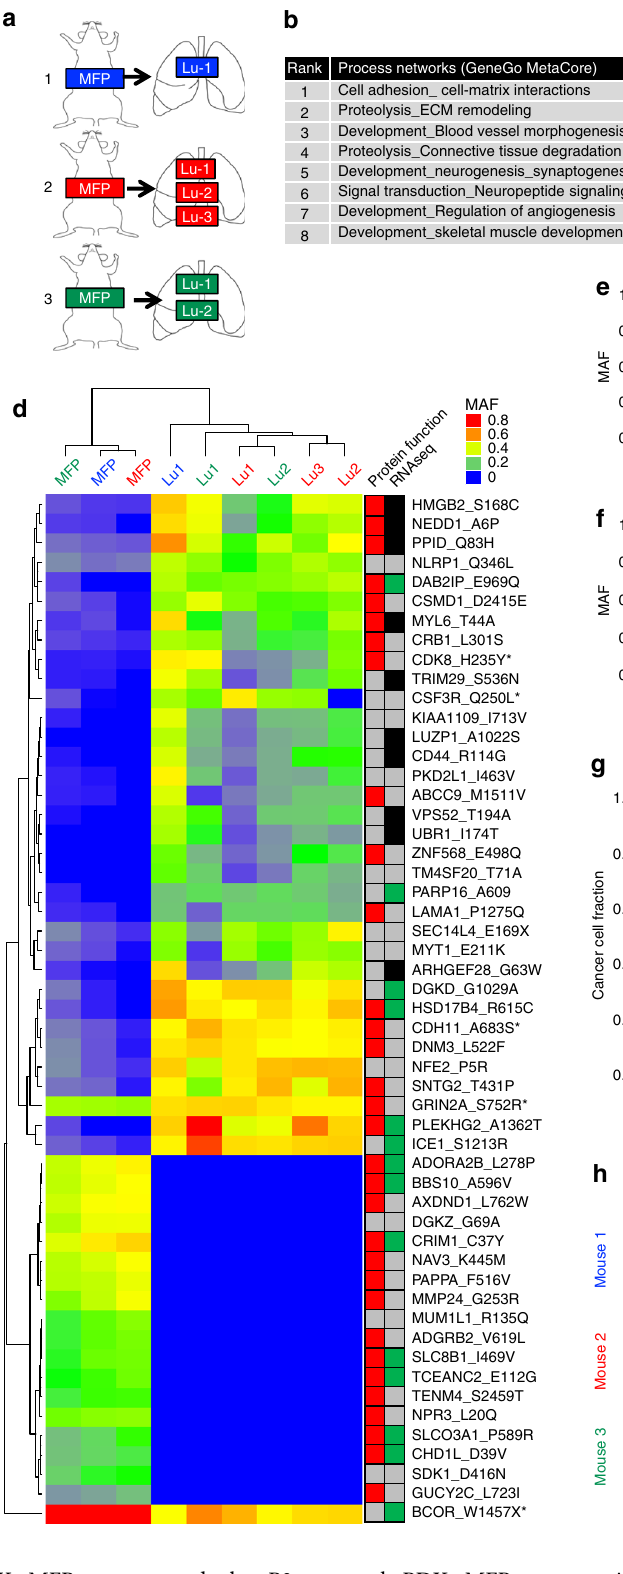
PDX MFP tumor, and the P3 parental PDX MFP tumor (Supplementary Figure 3). WES and targeted sequencing revealed ITH in primary tumors and metastases (Supplementary Figure 4). between the three replicate PIM1-CBRluc MFP tumors